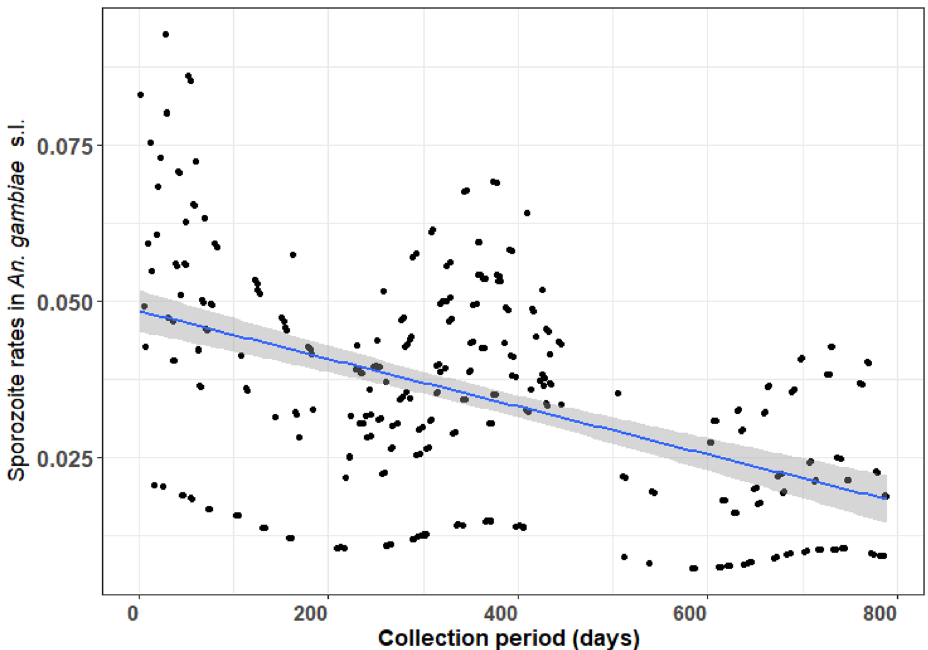
Figure 5. Mean predicted longitudinal trend in sporozoite infection rates in An. gambiae s.l. (dots). Data are from An. gambiae s.l. collected in 12 villages in southwestern Burkina Faso using Human Landing Catches between October 2016 and December 2018. The blue line indicates the predicted temporal trend with the grey- shaded areas indicating the 95% confidence